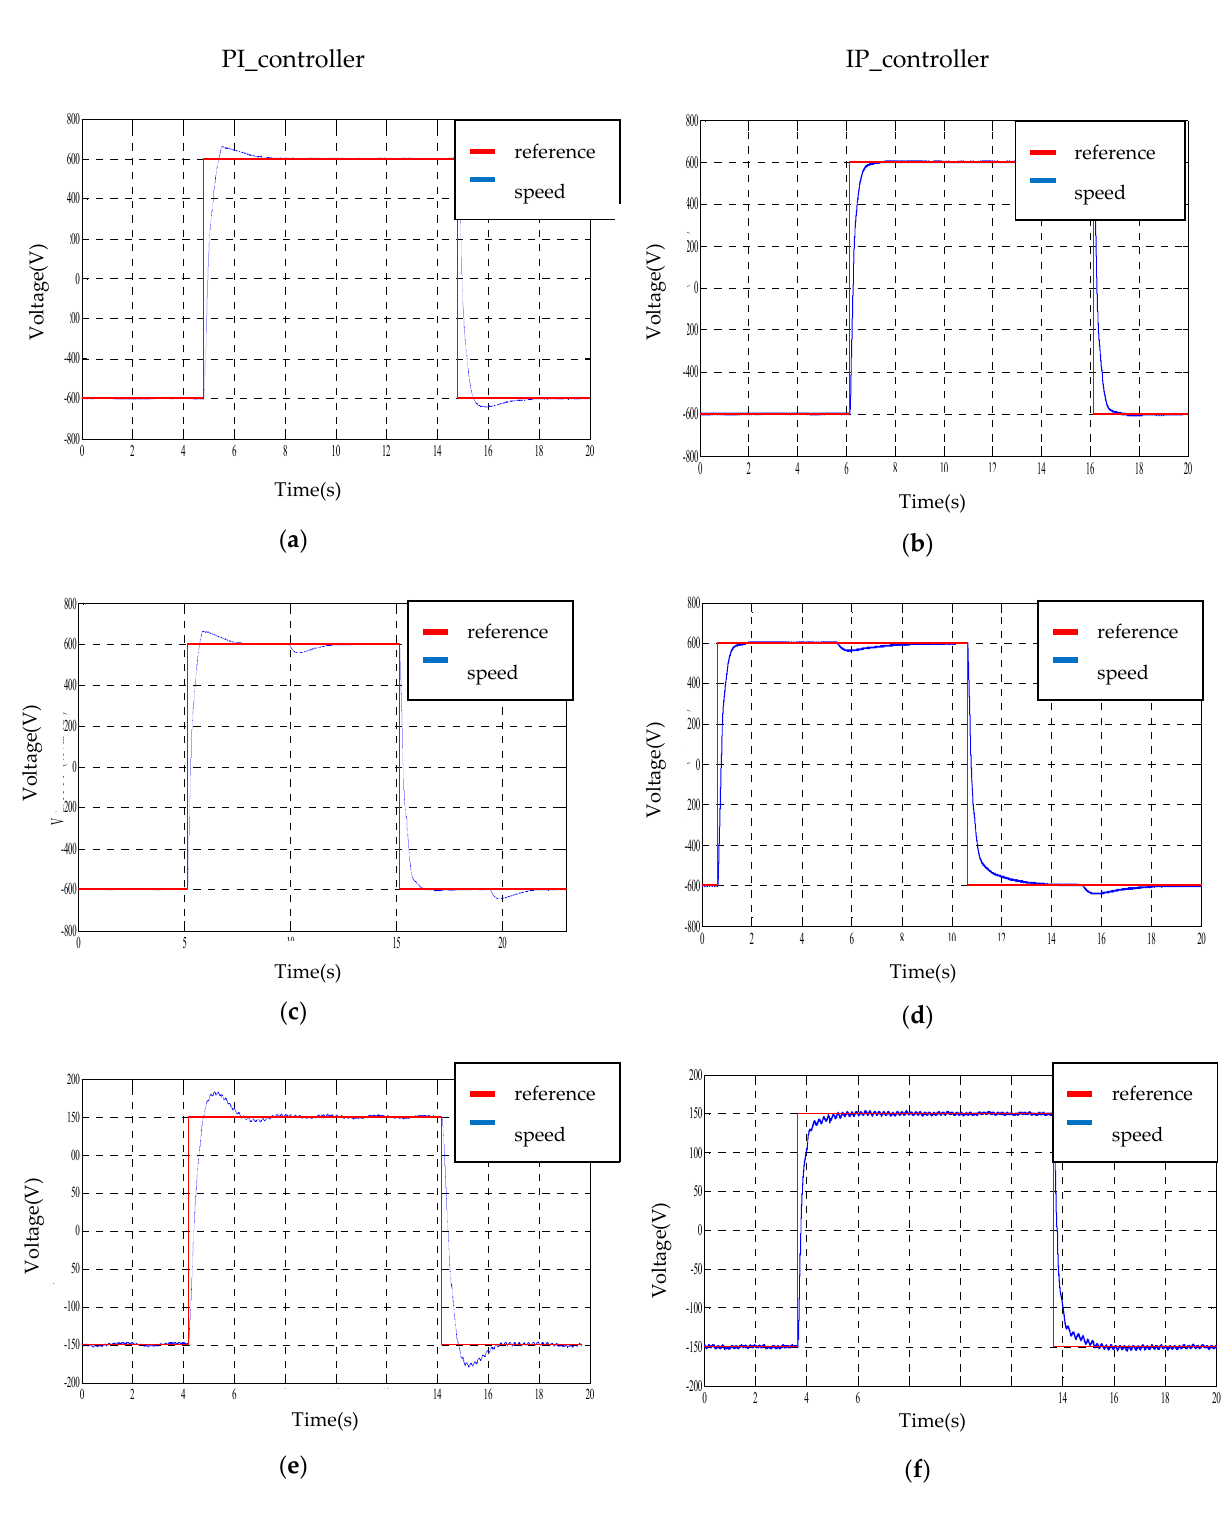
Figure 17. Comparison between 3L_FOC in closed loop conditions using PI and IP controller in terms of: ( a , b ) Medium speed response with changing direction; ( c , d ) Medium speed response with injecting perturbation; ( e , f ) Small speed response with changing direction.